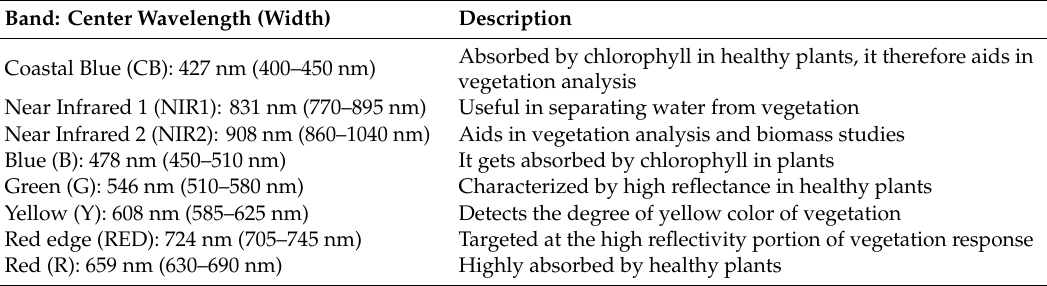
Table 1. Characteristics of the bands of WorldView-2 satellite